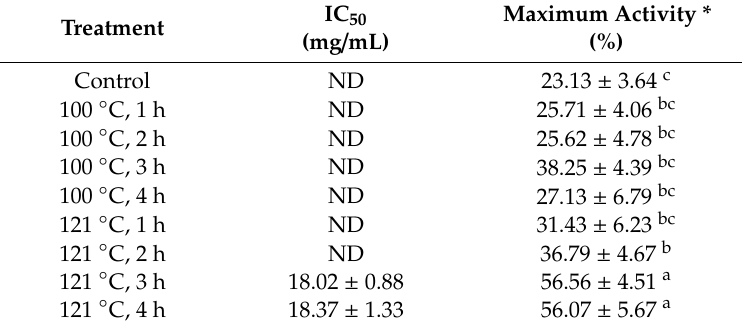
Table 3. Anti- α -amylase activity of the WSC and WSCGDs.